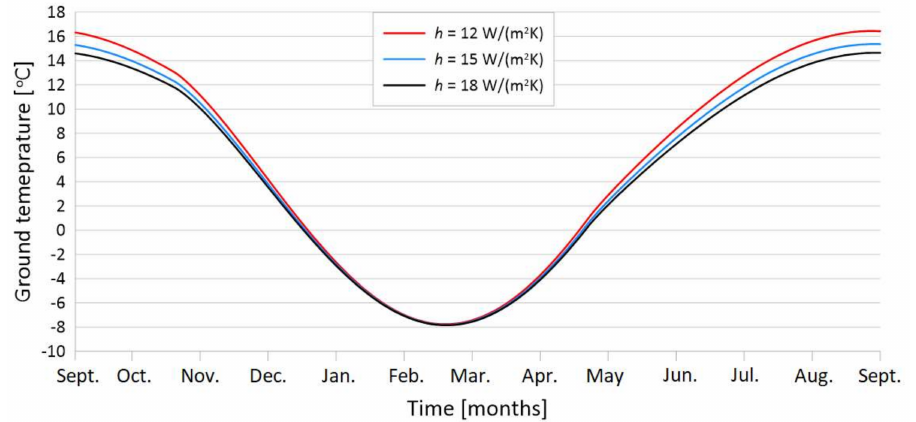
Figure 9. Influence of the convective heat transfer coefficient on the ground temperature at the depth of the heat exchanger’s installation.